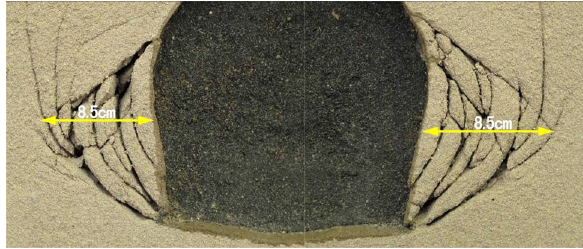
Fig. 9 Width of cracks in the M2 model